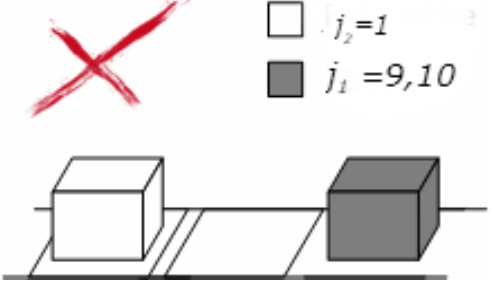
Figure 6. Diagram of Restriction